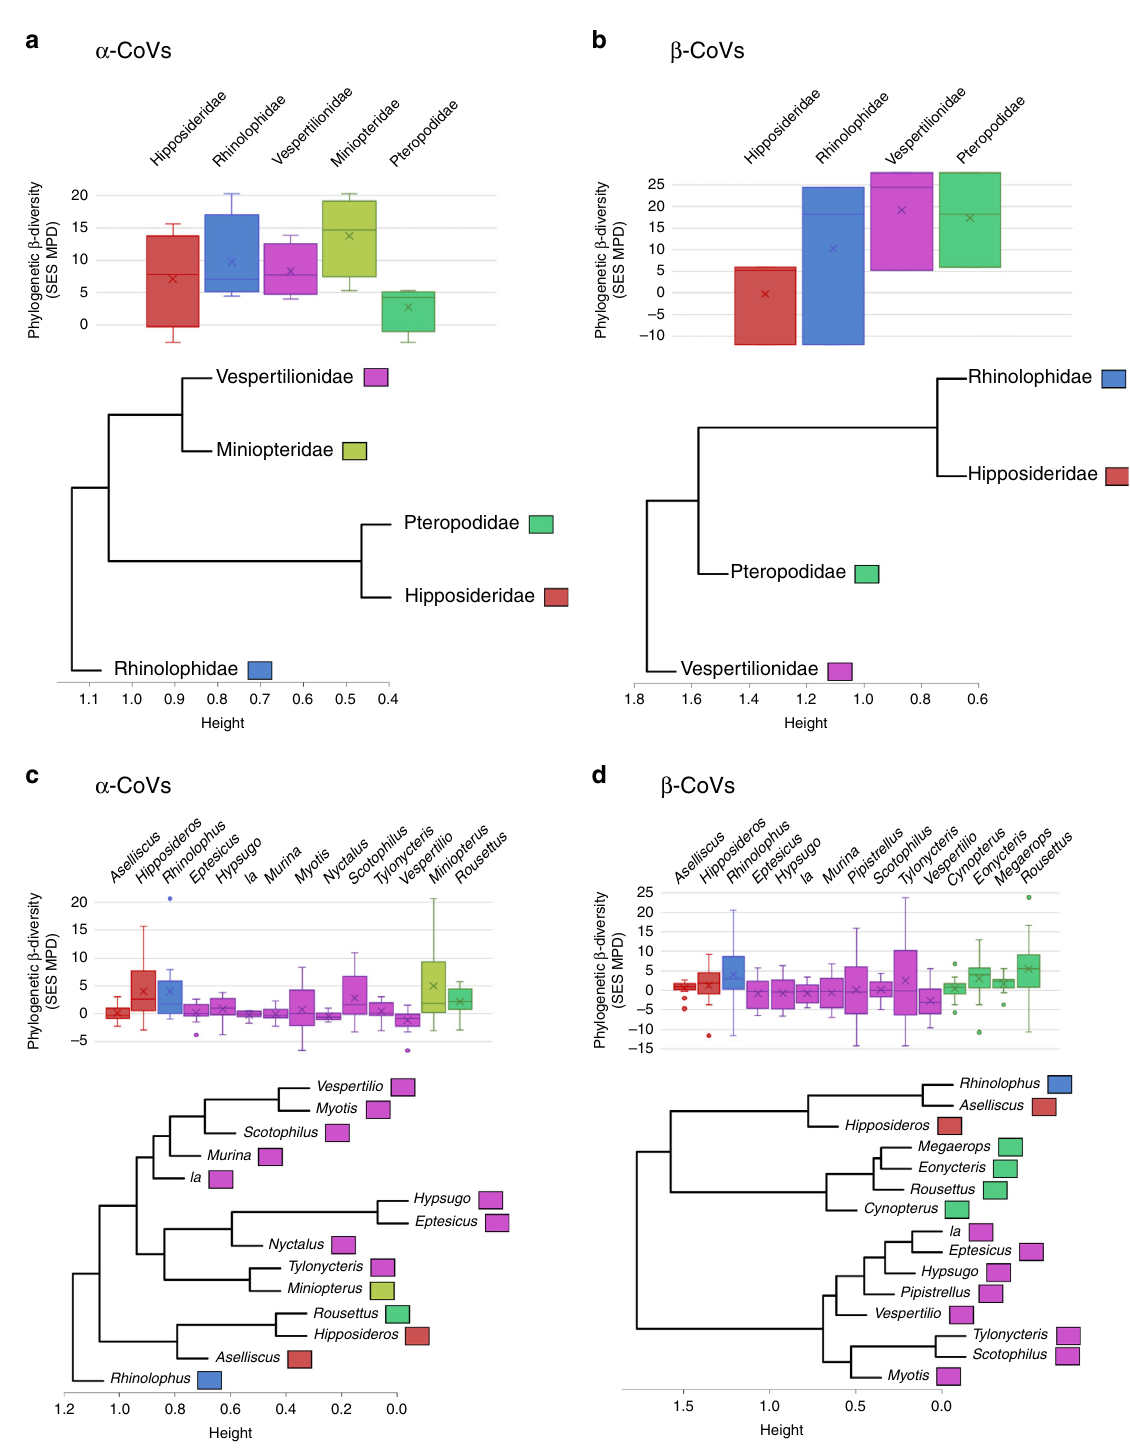
Fig. 8 Phylogenetic diversity. Standardized effect size of mean phylogenetic distance (SES MPD) and phylogenetic ordination among bat host families ( a , b ) and genera ( c , d ) for α - and β -CoVs. Boxplots for each host family and genus show the mean (cross), median (dark line within the box), interquartile range (box), 95% con fi dence interval (whisker bars), and outliers (dots), calculated from all pairwise comparisons between bat families ( n = 10 for α -CoVs and n = 6 for β -CoVs) and genera ( n = 91 for α -CoVs and n = 105 for β